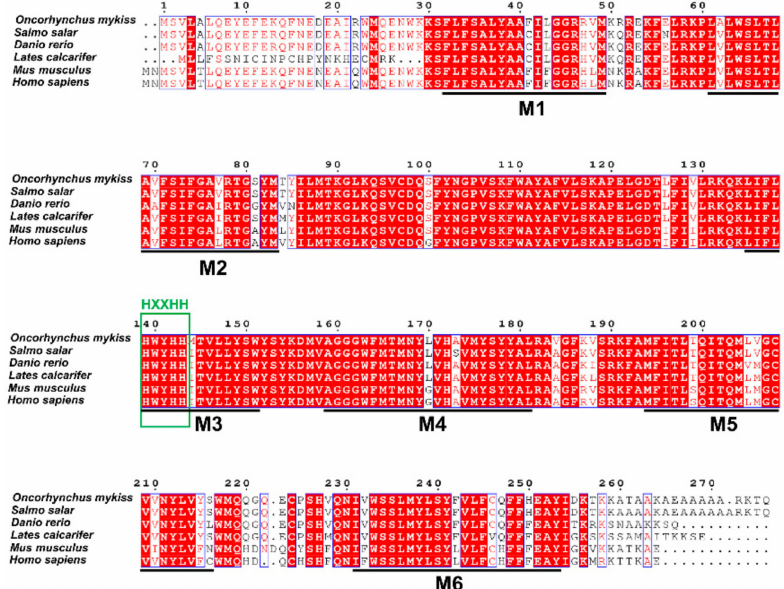
Figure 2. Amino acid alignment of Elovl6 amino acid sequence in rainbow trout with other species. The conserved HXXHH histidine box motif (green box) and putative membrane-spanning domains (M1–M6) are indicated. The blue boxes represent the conserved sequence. The identity shading is based on 87% identity